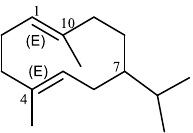
Figure 1. Molecular structure of 1(10),4-germacradiene.